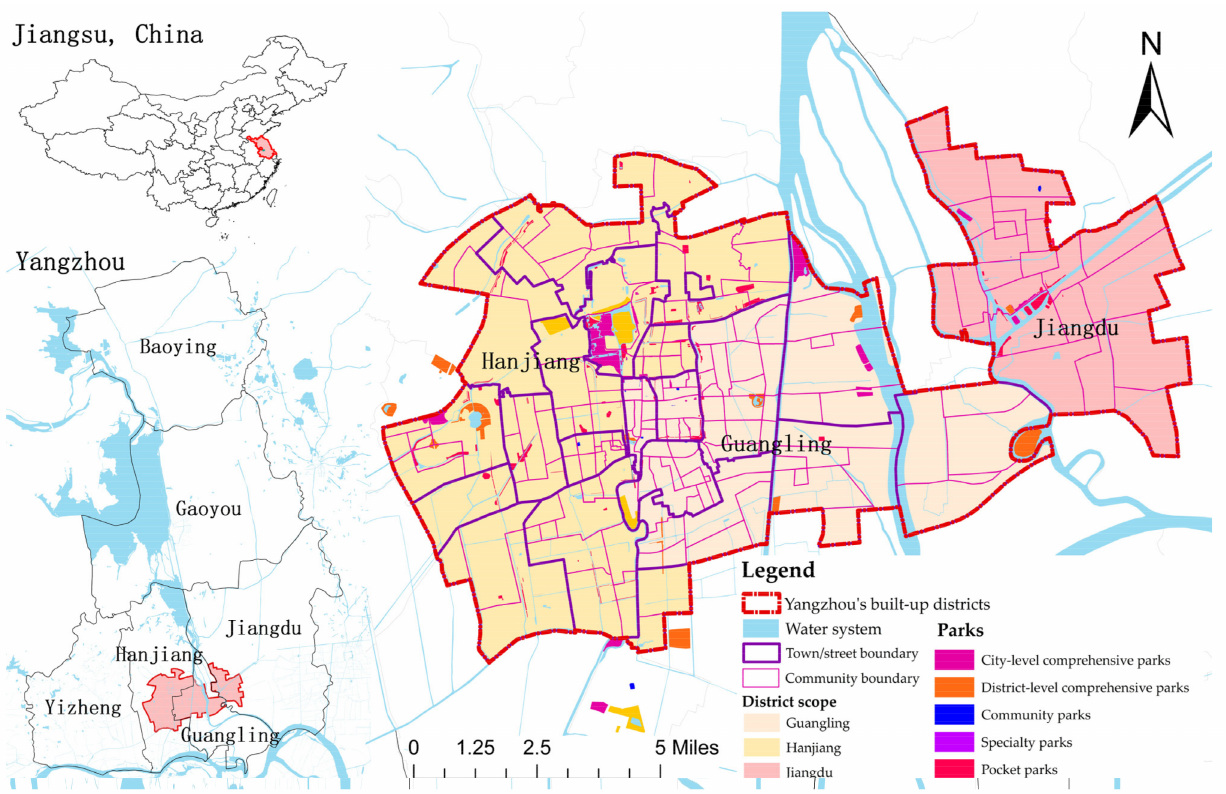
Figure 3. Study area and park